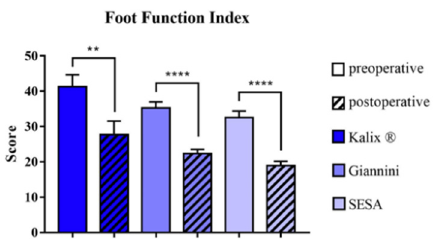
Figure 6. Pre- and postoperative total foot function index. Patient treatment satisfaction was meas- ured before and at the end of treatment with Kalix ® implants, Giannini implants or subtalar ex- traarticular screw arthroereises (SESA). ( μ ± SEM, Wilcoxon signed-rank test, ** = p < 0.01, **** = p < 0.0001).